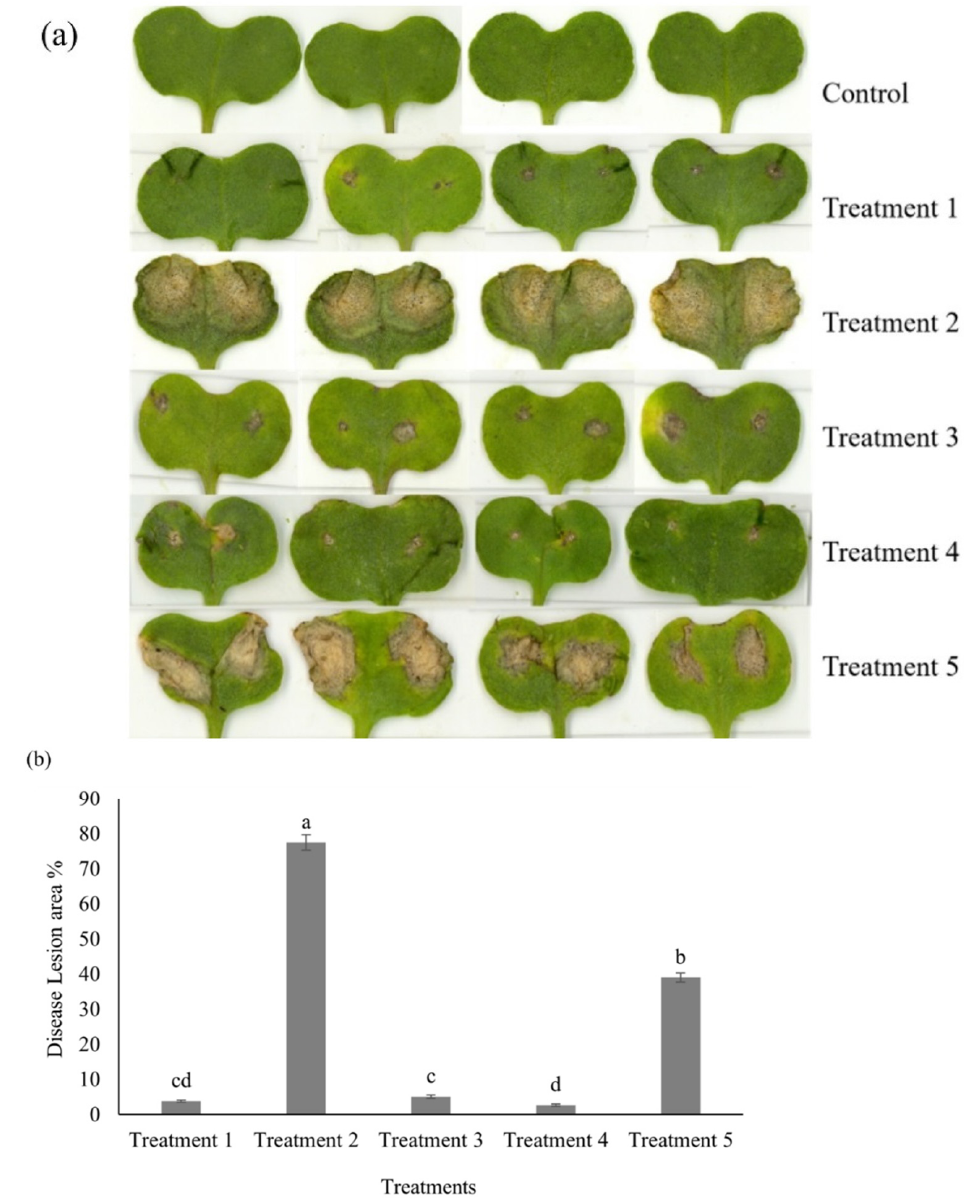
Figure 1. Blackleg disease lesion development in Westar cotyledons at 14 days post-inoculation under controlled conditions with Leptosphaeria maculans ‘brassicae’ and L. biglobosa ‘brassicae’ inoculations. Seven-day-old cotyledons were wound inoculated and observed the lesion development in time course. Cotyledons inoculated with only GFP-tagged L. maculans (LmGFP) and cotyledons pre- inoculated with LmGFP showed significantly higher lesion development at 14 dpi. Control: distilled water treatment; Treatment 1: LbDsRed inoculation; Treatment 2: LmGFP inoculation; Treatment 3: LbDsRed and LmGFP co-inoculation; Treatment 4: LbDsRed followed by LmGFP inoculation (in 24 h intervals); Treatment 5: LmGFP followed by LbDsRed inoculation (in 24 h intervals). ( a ) Scanned images of disease lesion development in cotyledons; ( b ) Lesion size shown as a percentage of the total leaf area of both host types calculated by ImageJ. Different letters refer to significant differences between treatments ( p ≤